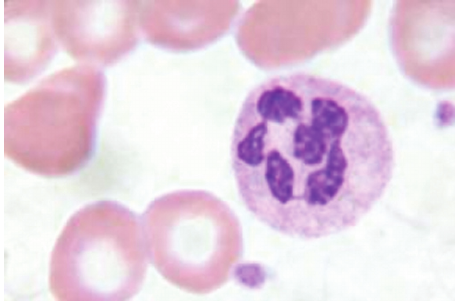
Figure 4 Peripheral bloods smear from a patient with megaloblas- tic